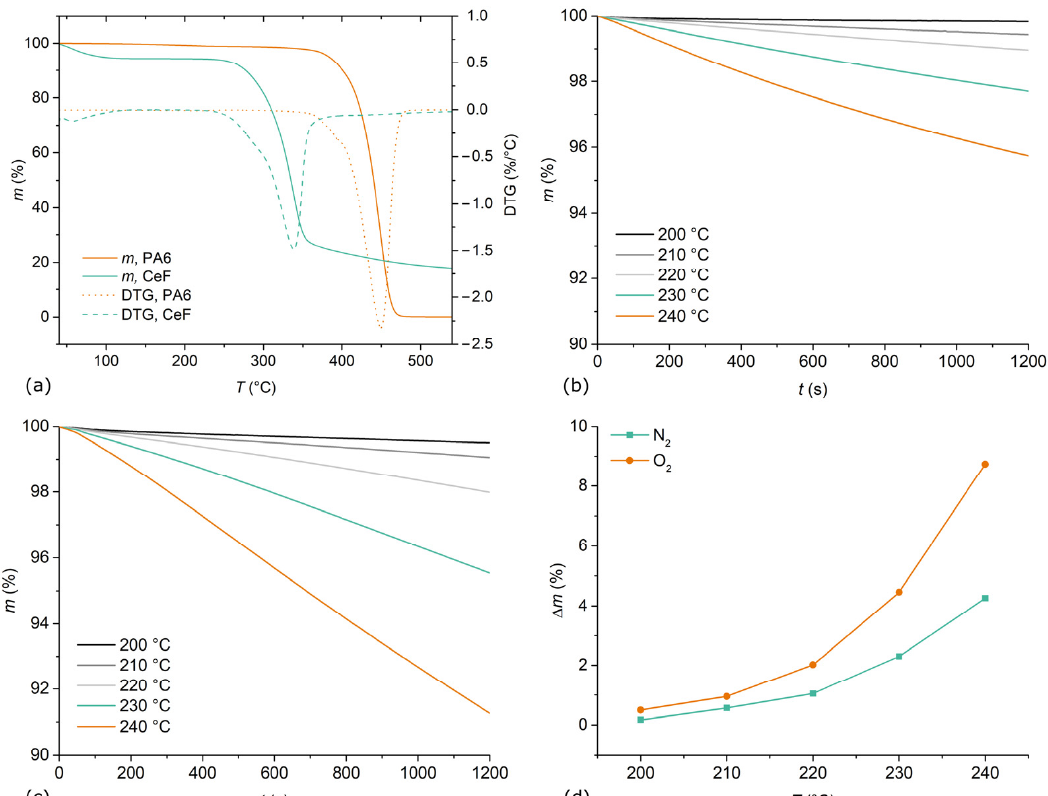
Figure 2. TGA results: ( a ) non-isothermal measurement of PA6 and CeF; ( b ) isothermal measurements of CeF in N 2 atmosphere; ( c ) isothermal measurements of CeF in O 2 atmosphere; ( d ) comparison of Δ m at 20 min for isothermal TGA measurements.